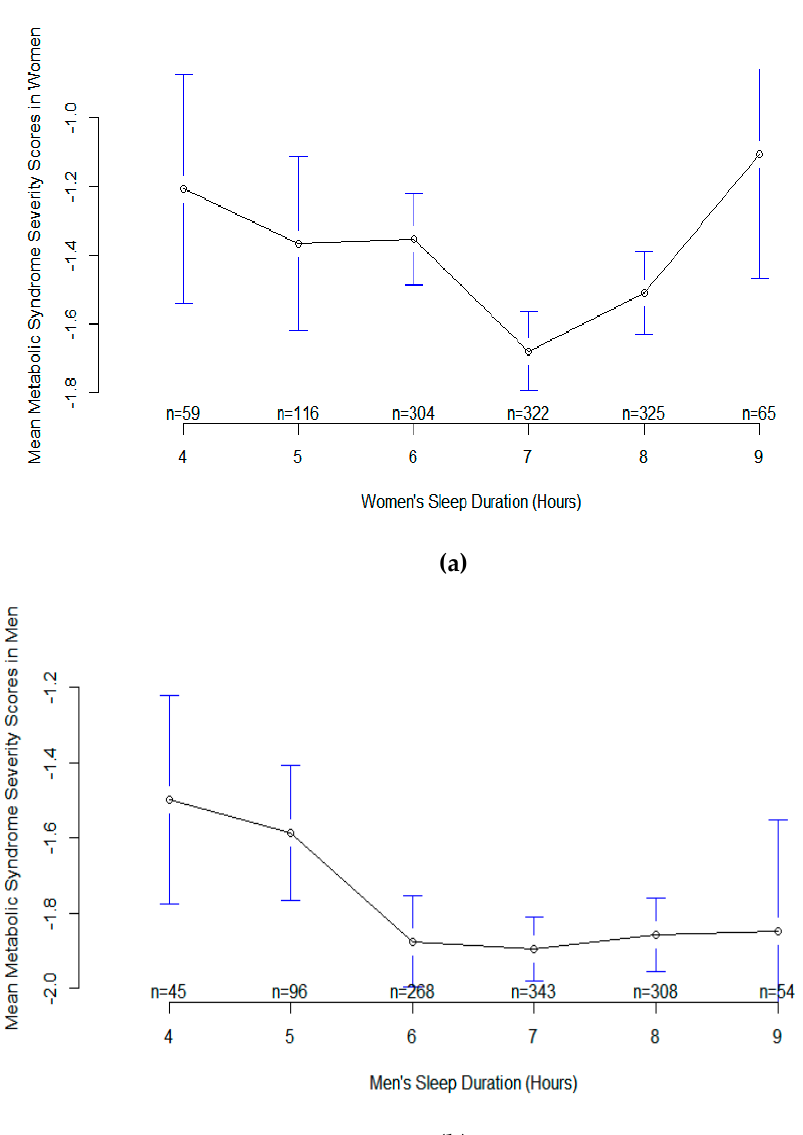
Figure 6. Plots of sleep duration vs. mean metabolic syndrome severity score in women (upper plot) and men (lower plot). ( a ) Plot of sleep duration vs. mean metabolic syndrome severity score in women. ( b ) Plot of sleep duration vs. mean metabolic syndrome severity score in men.